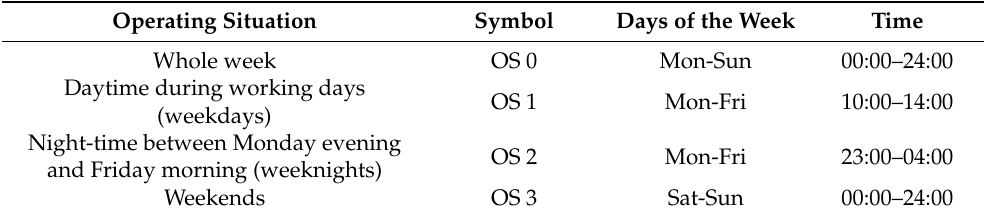
Table 1. The different operating situations (OS) used in the study. The daytime/night-time hours were selected as a little bit shorter compared to full working day to include only times of full/no